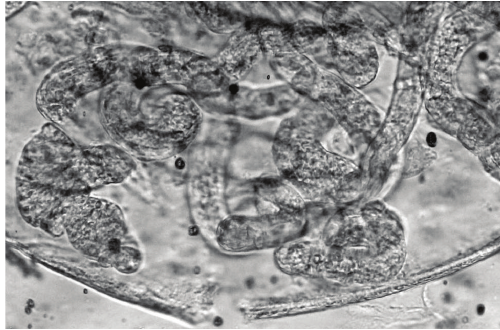
Figure 18: Juveniles developing inside the body of the female allantonematid shown in Figure 17.